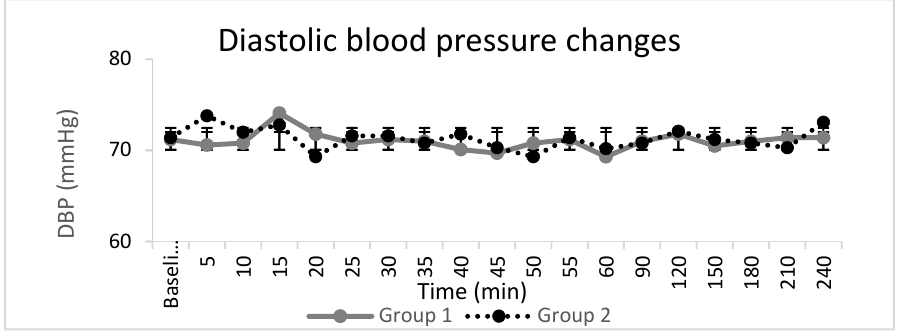
Figure 4. Diastolic blood pressure changes (DBP). The line graphs represent the mean and standard deviation in Group 1 and Group 2.